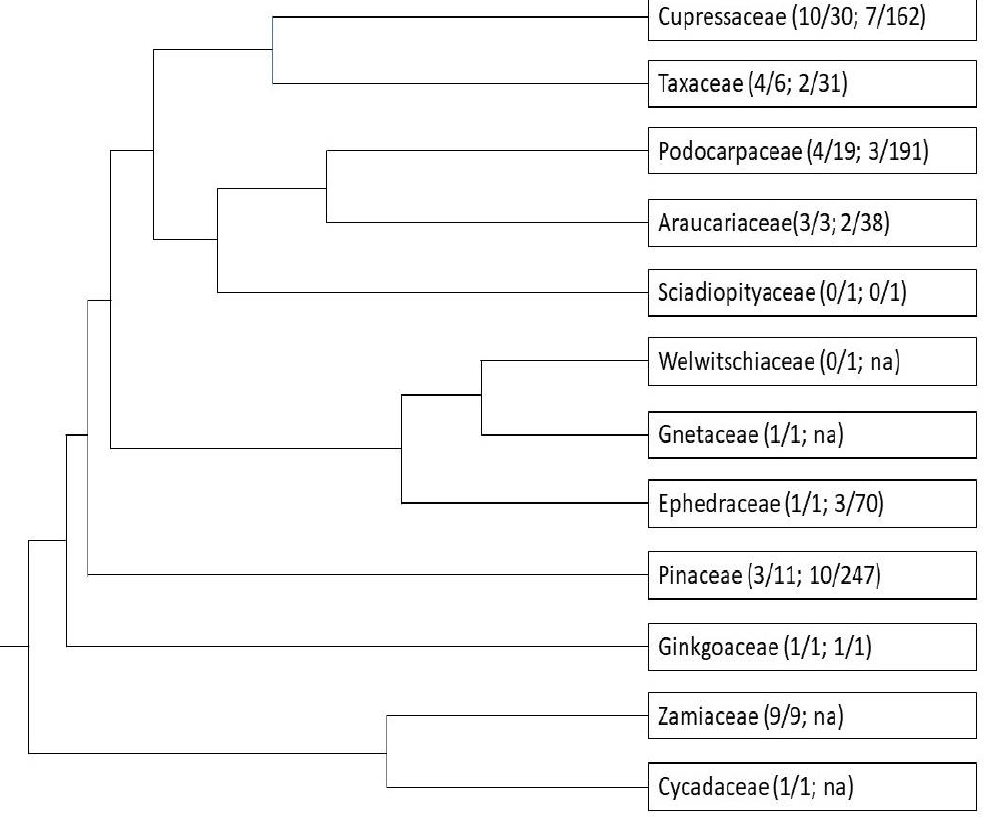
Figure 3. Phylogeny of extant conifer families (adapted from Figure 5 of Lu et al. [23] ). Numbers in brackets represent number of resprouting genera/number of genera in the family; number of species resprouting after 100% leaf scorch/total number of species in the family.